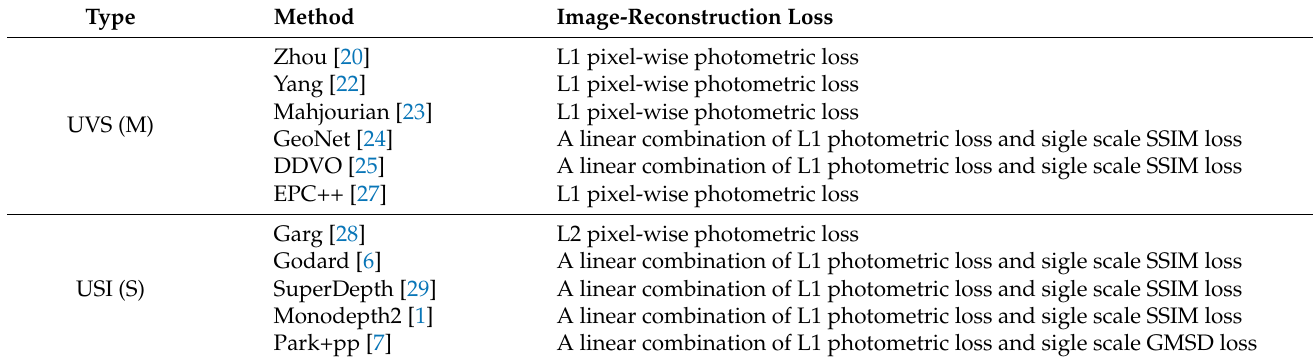
Table 1. Image-reconstruction loss of each unsupervised learning-based depth prediction